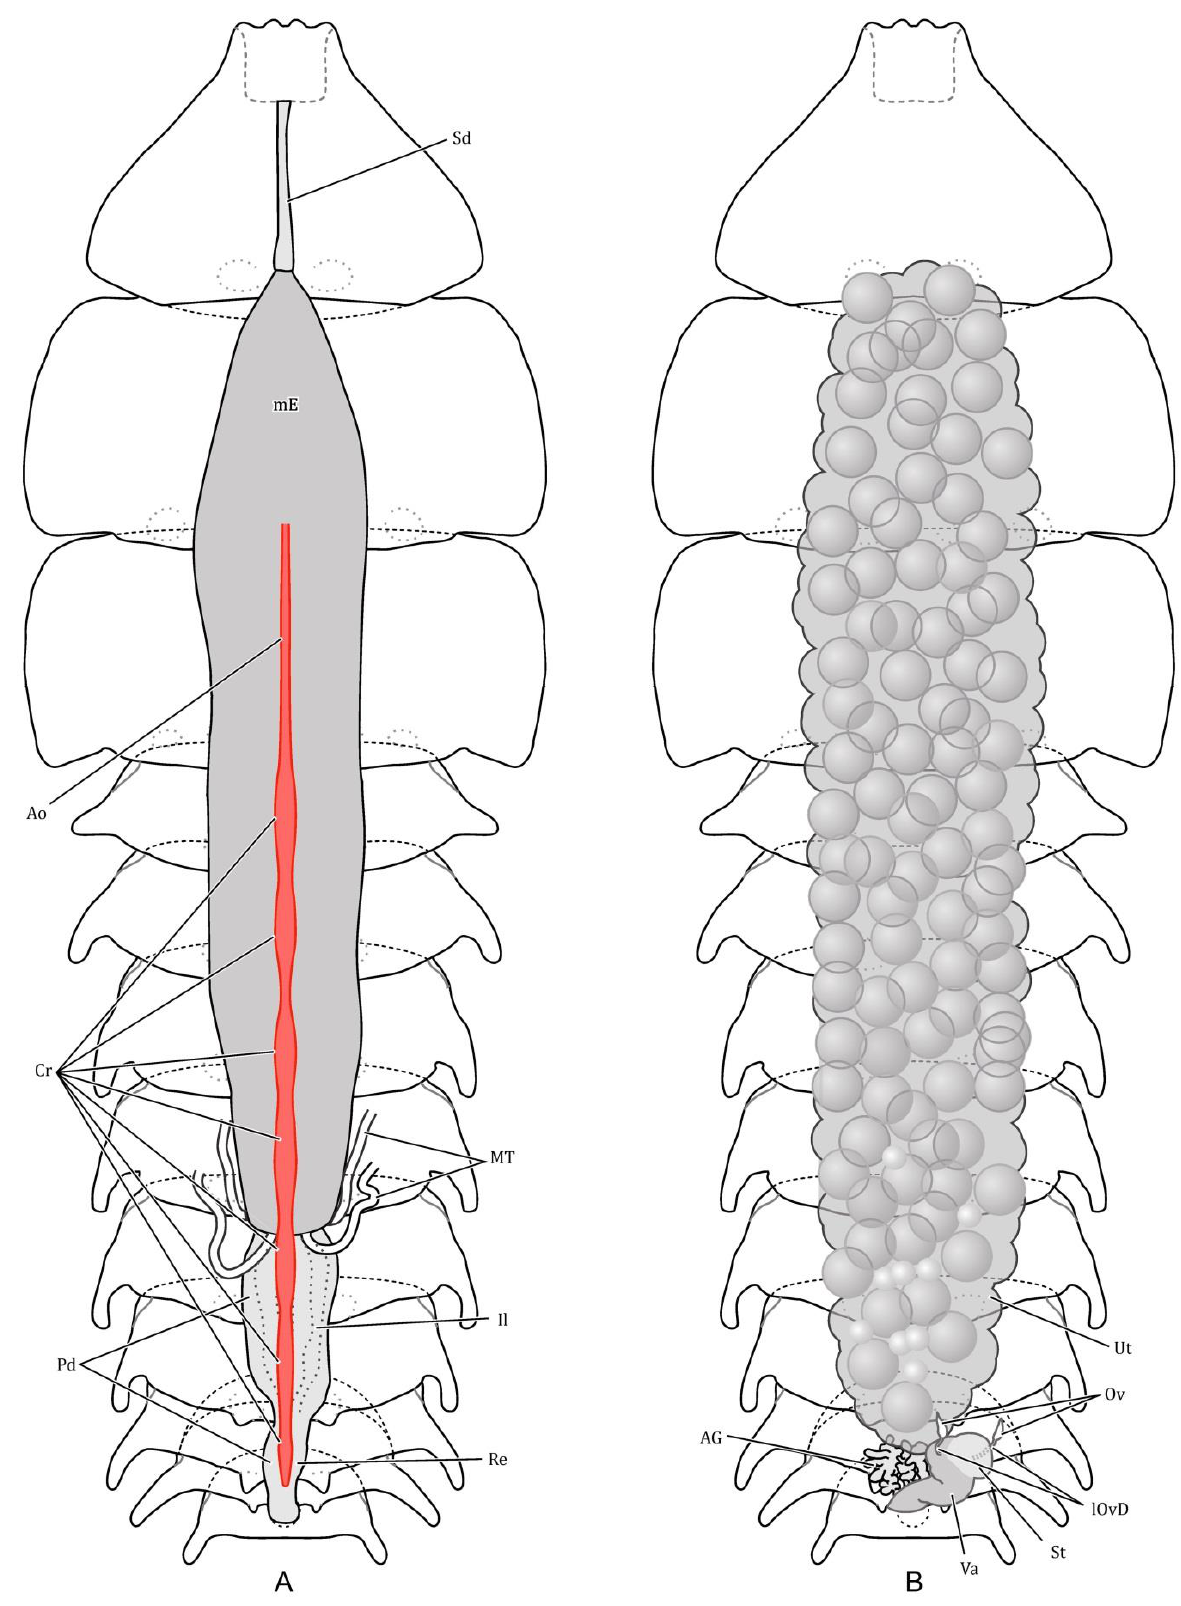
Figure 12. Platerodrilus svetae , female, ( A ) — heart and digestive system; ( B ) — reproductory system. Explanations in text.